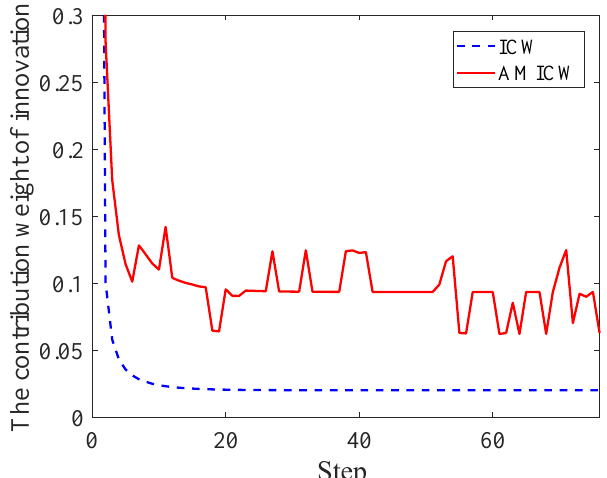
Figure 3. The changes of innovation contribution weight (ICW) and adaptive modified innovation contribution weight